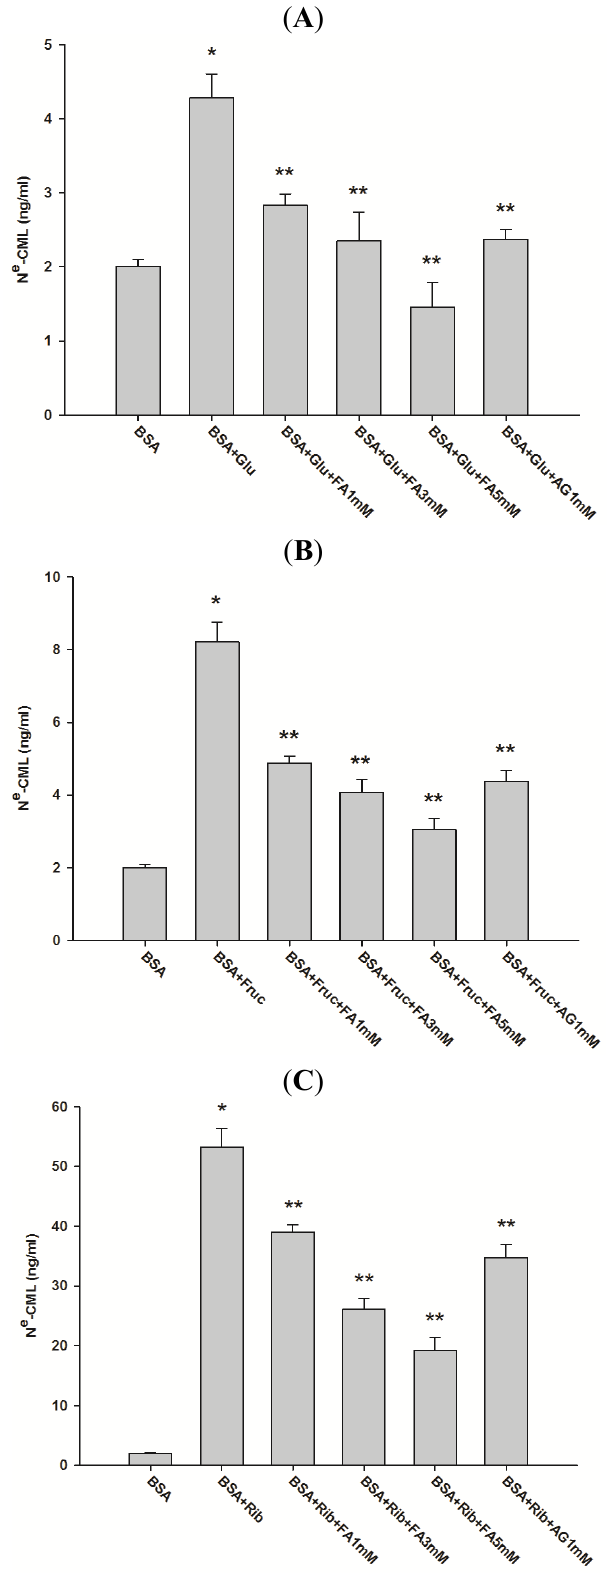
Figure 3. Effect of FA on non-fluorescence AGEs level (N ε -CML) in BSA incubated with glucose ( A ), fructose ( B ) and ribose ( C ) at week 4. The results are expressed as mean ± SEM ( n = 3). * p < 0.05 when compared to BSA, ** p < 0.05 when compared to BSA+glucose, BSA+fructose or BSA+ribose. AG was used as positive